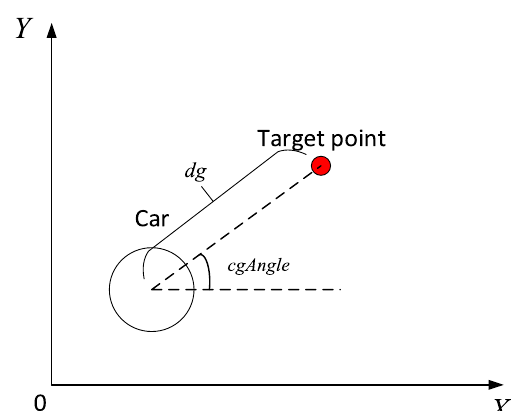
Fig. 6 The position of the vehicle relative to the